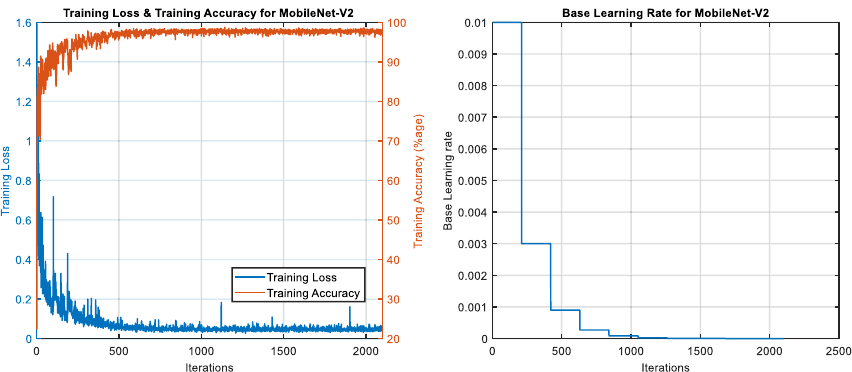
Fig. 11 Plot for training loss, accuracy, and base learning rate for